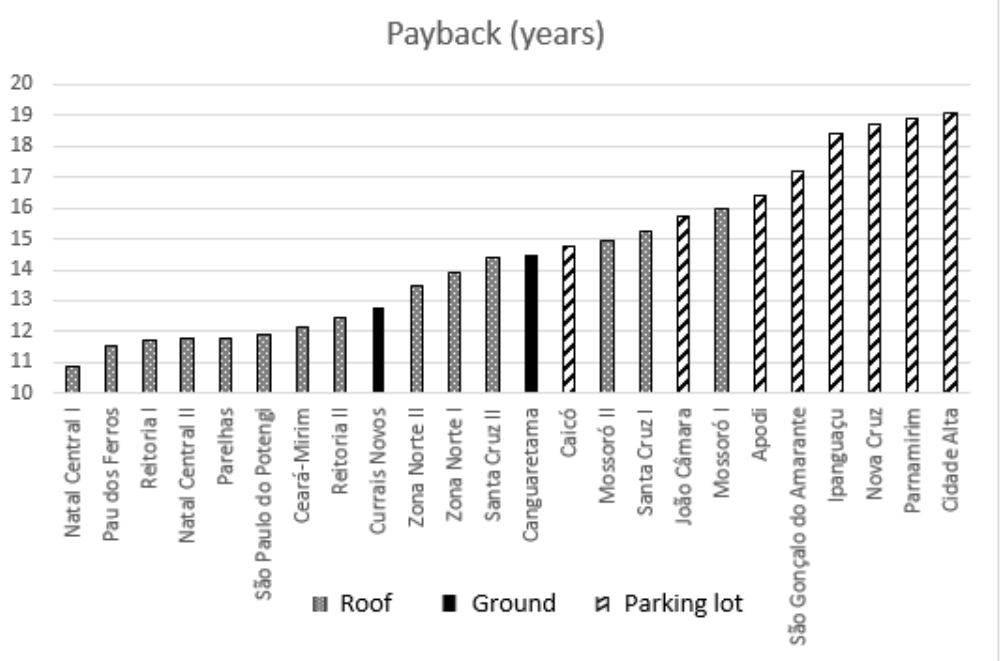
Figure 7. Current payback of the IFRN-Solar project plants.